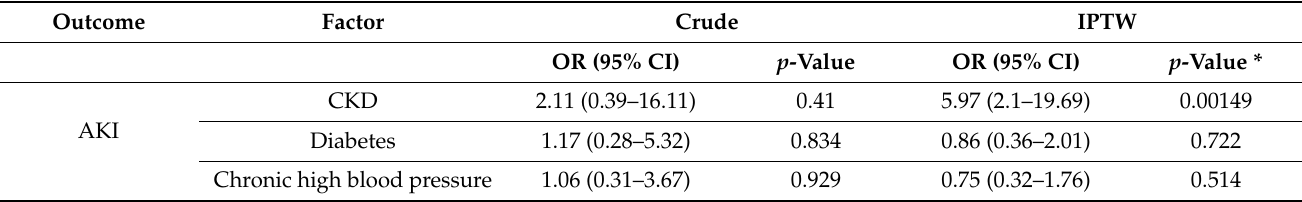
Table 5. Comparison of the incidence of acute kidney injury (AKI) according to major